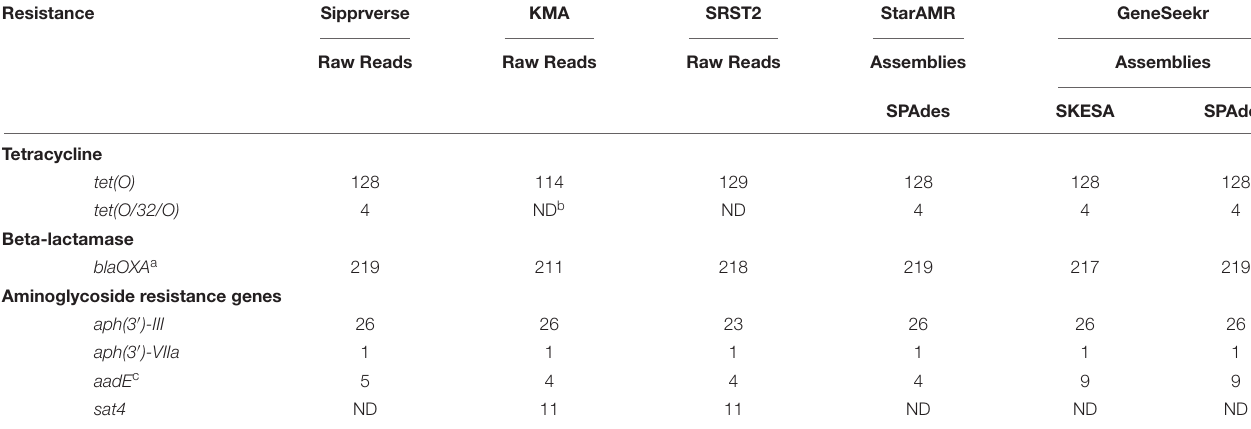
a Represents all blaOXA genes identified; class of blaOXA gene was predicted for some isolates using StarAMR, KMA and SRST2 (include OXA-61, OXA-184, OXA-193, OXA-448, OXA-449, OXA-465, OXA-466, and OXA-489). b ND = none detected. c Only identified in C. coli isolates.